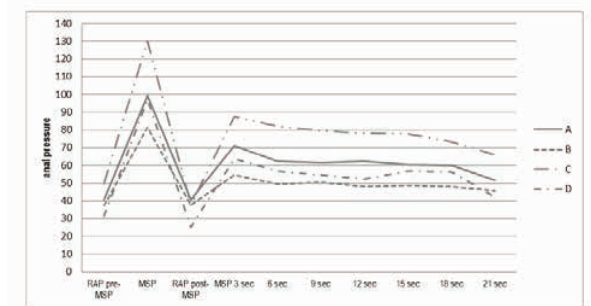
Figure 2: Comparison between resting anal pressure in mm Hg (RAP) measured before and after maximum voluntary contraction in the four patient